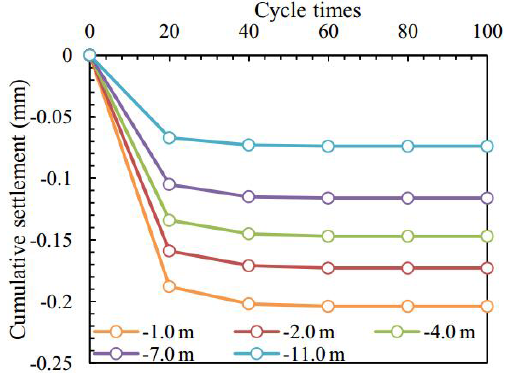
Figure 7. Cumulative settlement under different cyclic times.